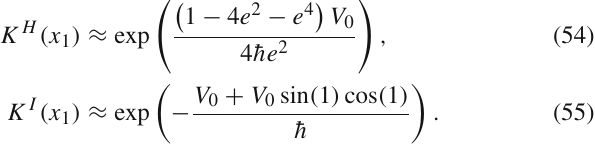
anti-instanton. The instanton corresponds to the particle ini- tially sitting on the maximum of − V ( x ) at x = − a , passing x = 0 for a very short time and ending up at the other maxi- mum of − V ( x ) at x = a . From the instanton the Euclidean action is given